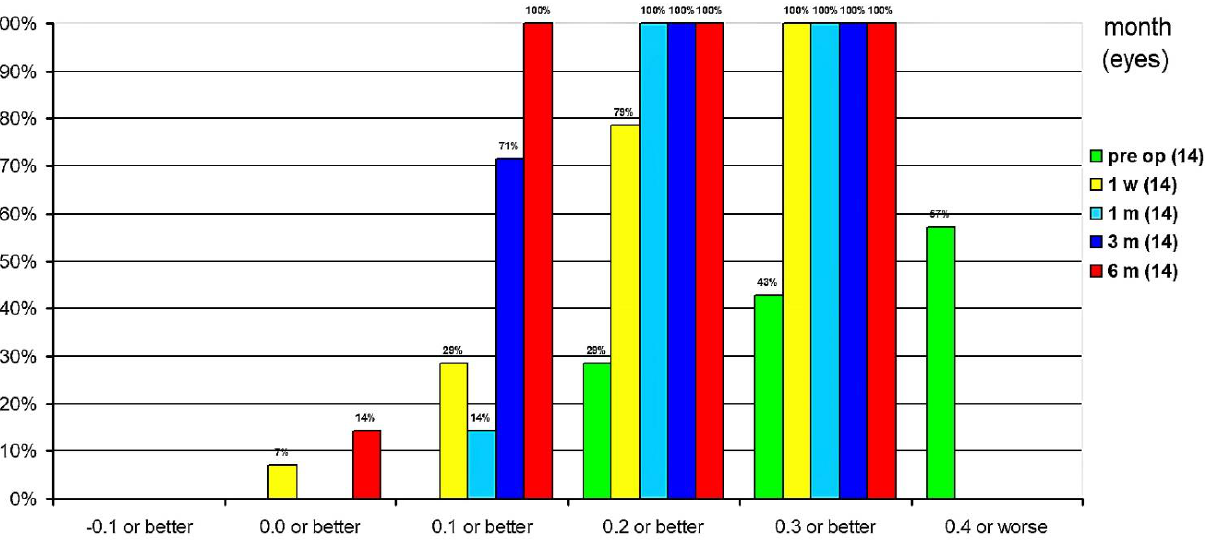
Figure 12. Cumulative uncorrected distance visual acuity.